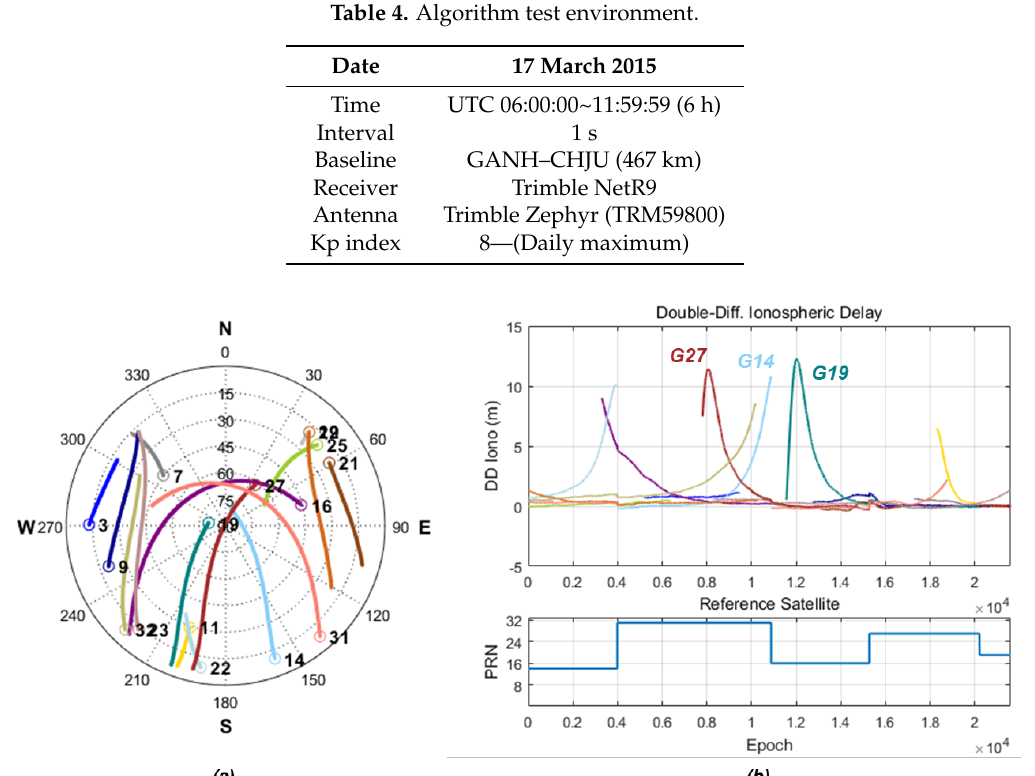
Figure 9. ( a ) Sky plot in the CHJU station; ( b ) double-differenced ionospheric delay (RTK results).